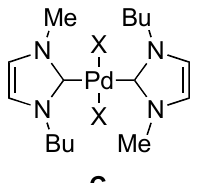
Figure 22. Isolated carbene palladium